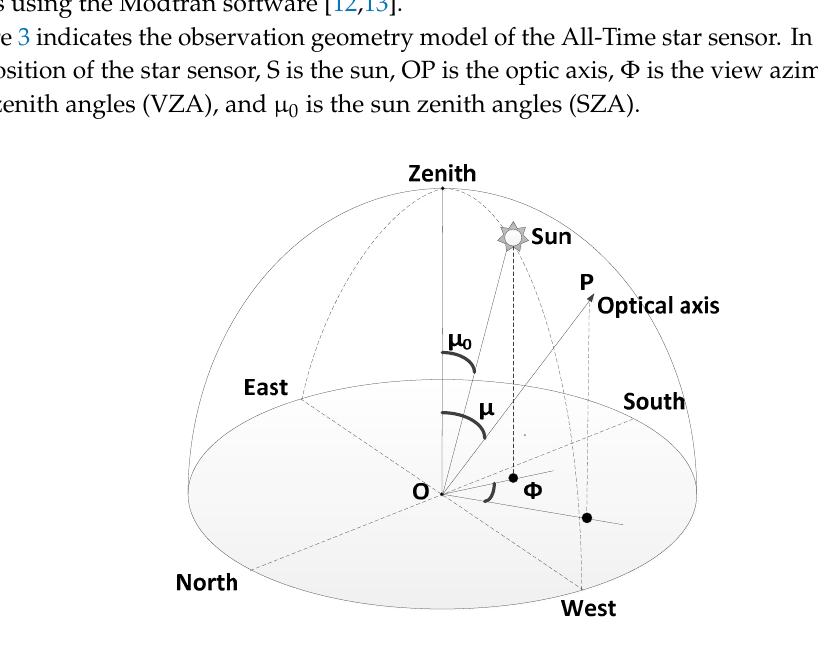
Figure 3. Observation geometry model of the All-Time star sensor